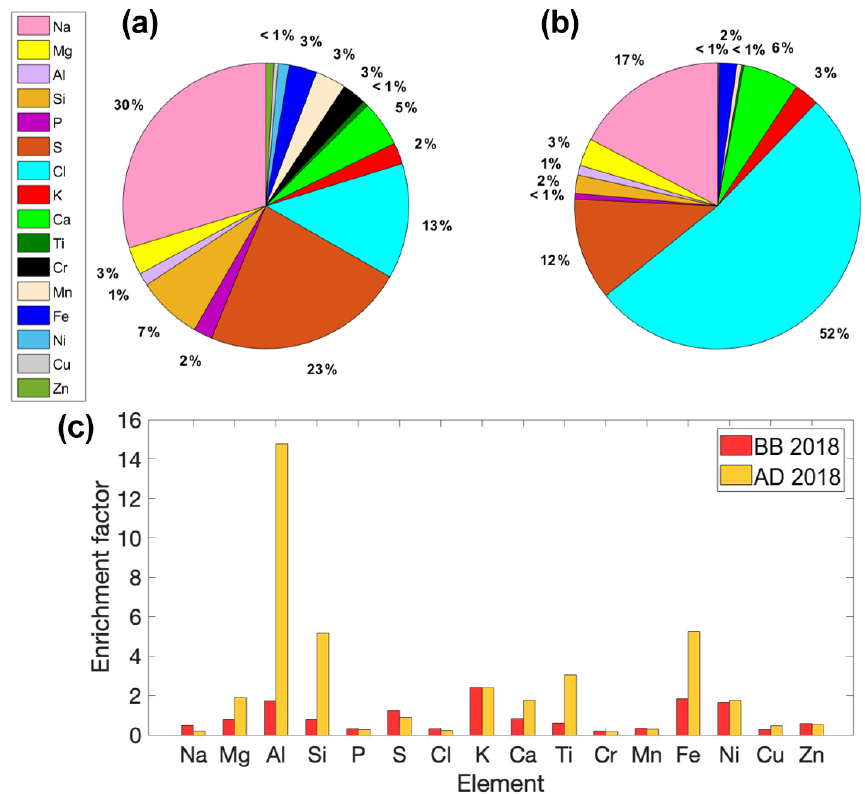
Figure 5. Percentage of elemental mass concentrations for background samples in Mérida (a) and Sisal (b) . Enrichment factors are calculated for samples obtained under the influence of BB (red bars) and AD (yellow bars) plumes from background conditions in Mérida (c) .